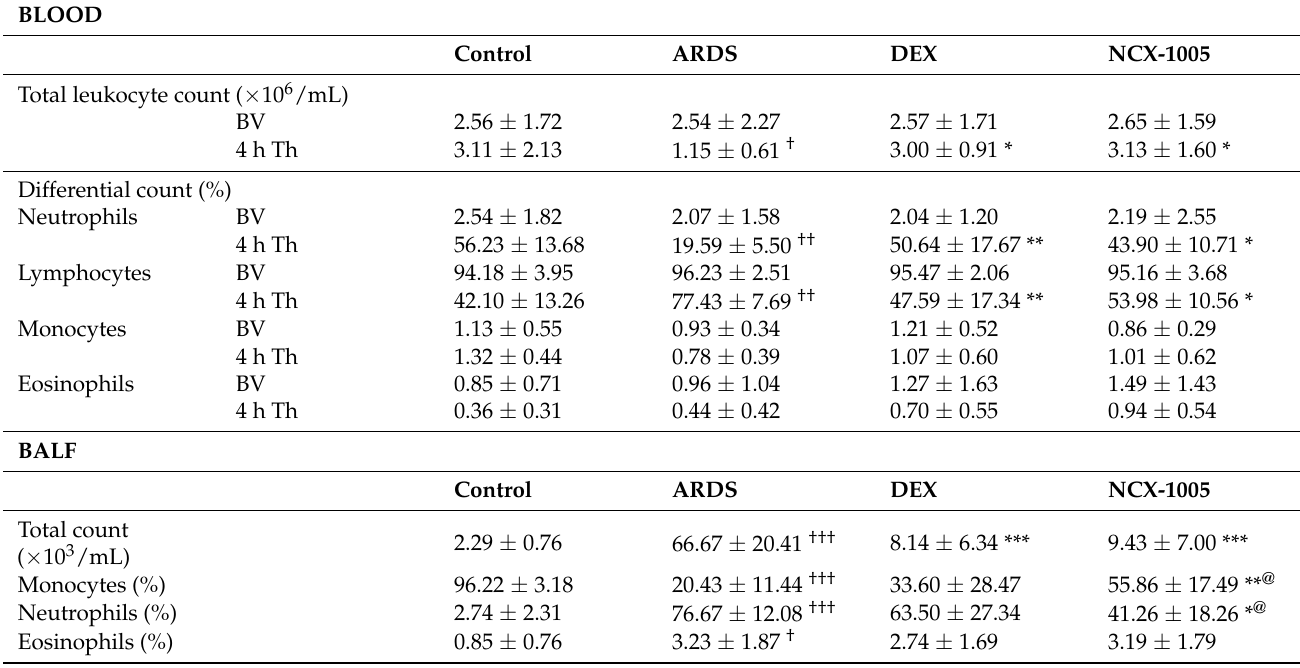
Table 2. White blood cell count. Total and differential leukocyte count in the blood before (basal value, BV) and in the 4 h of the therapy (Th); and in the bronchoalveolar lavage fluid (BALF) in Control group, ARDS-untreated group, and ARDS group treated with dexamethasone or with